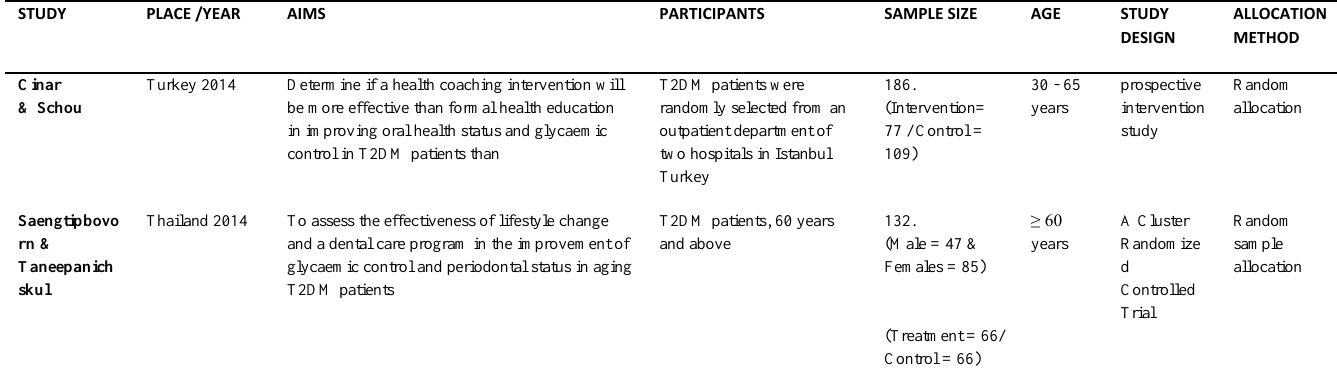
Table 1A: Characteristics of Included Studies